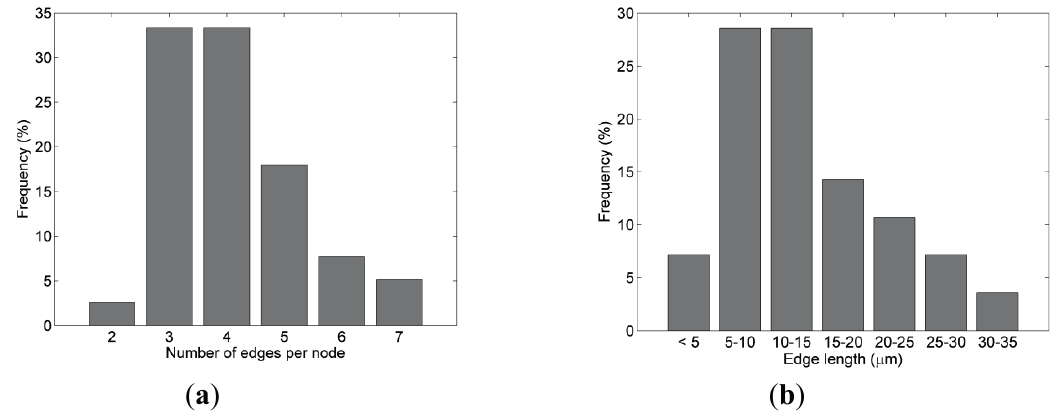
Figure 8. Statistical properties of the generated FRC network. The histograms of ( a ) the number of edges per node and ( b ) the edge